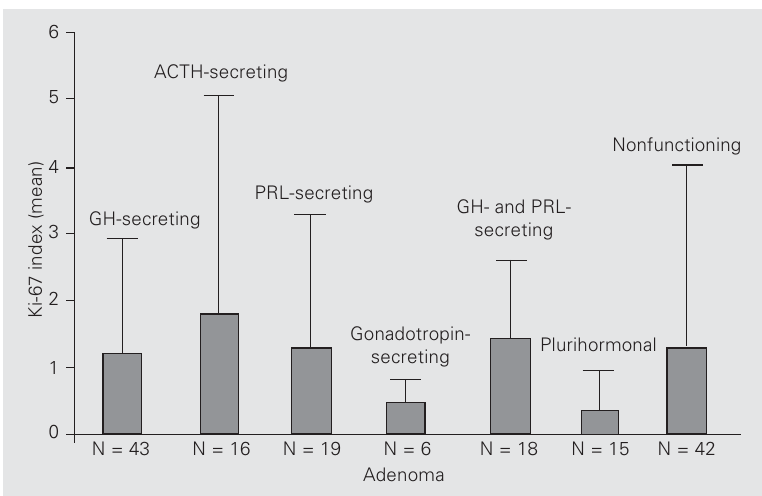
Figure 1. Ki-67 index and different patterns of hormone secretion. The Ki-67 index was determined with MIB-1 monoclonal antibodies and represents percent labeled cells. ACTH = adrenocorticotropic hormone; GH = growth hormone; PRL = prolactin.